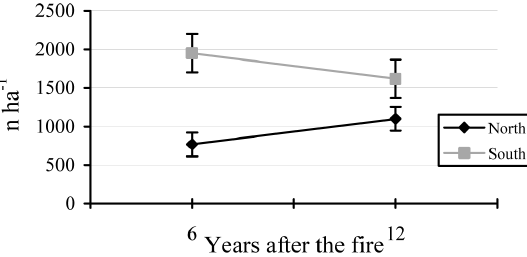
Figure 6. Stem density of P. brutia mixed stands on northern and southern aspects, 6 years (from Tsitsoni et al. 2004b) and 12 years after the